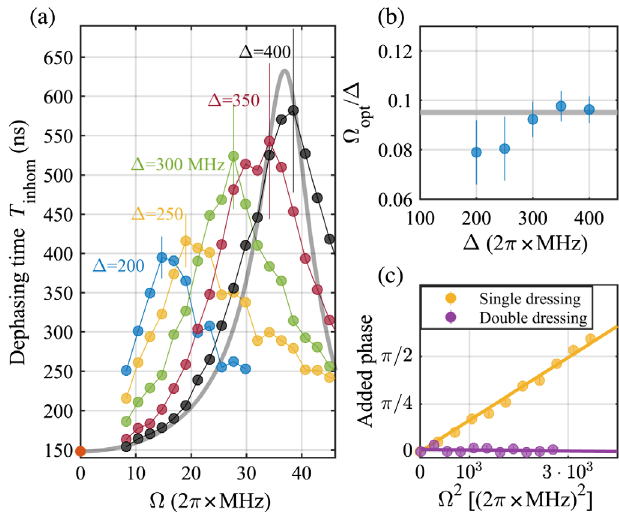
FIG. 5. Dependency of coherence time and accumulated phase on the dressing parameters. (a) Inhomogeneous dephasing time T , with double-dressing protection as a function of dressing inhom Rabi frequency Ω , for different detunings Δ (in 2 π × MHz). The shaded gray line is a theoretical model, where the dephasing rates due to linear and cubic dependencies on δ are summed in = Δ , where Ω quadrature. (b) Ratio Ω is the Rabi frequency opt opt maximizing the gain for each Δ , compared to the model prediction 2 − 3 = 2 J − 1 0 ½ð s − 1 Þ = ð s þ 1 Þ(cid:2) ≈ s − 1 ≈ 0 . 095 (solid line). (c) Phase accumulated due to the dressing fields during a storage time of 40 ns. Here, Δ ¼ 2 π × 480 MHz. Solid lines are linear fits. For double dressing, the added phase is zero (up to the experimental uncertainty) and is independent of the dressing